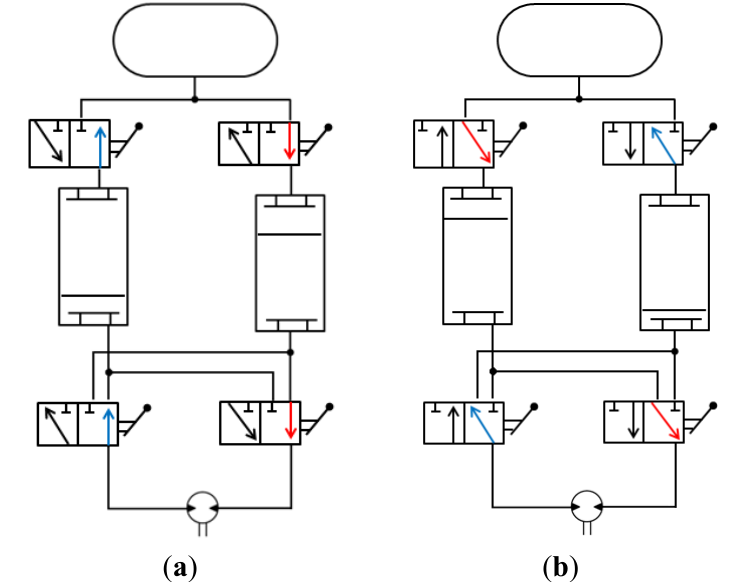
Figure 2. The system working process. ( a ) The phase A and ( b ) the phase